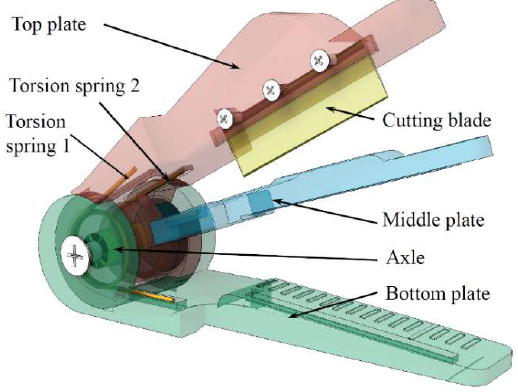
Figure 2. The 3D view of the proposed gripper [35,36].